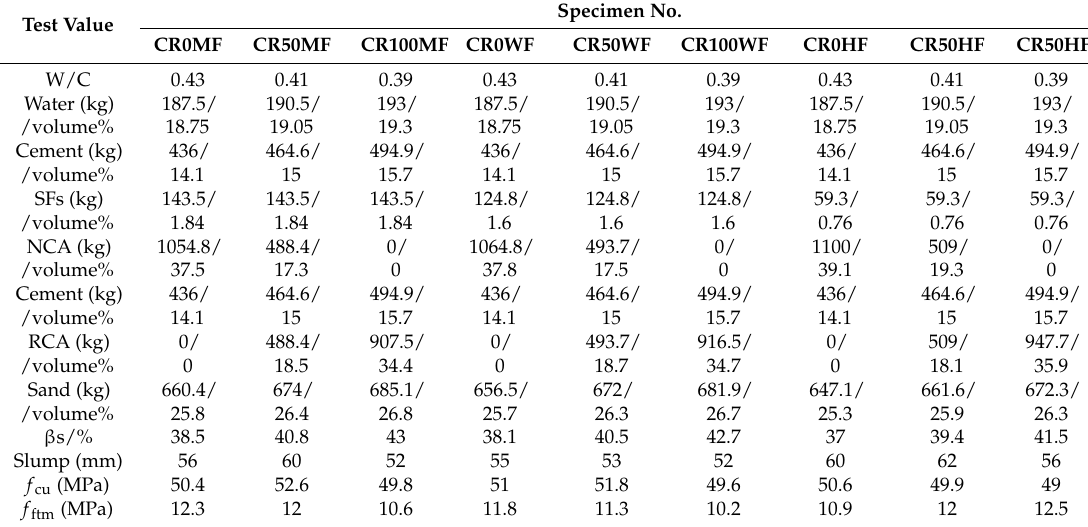
Table 8. Mix design details of SFRCAC based on new method, test results of slump and compressive and flexural